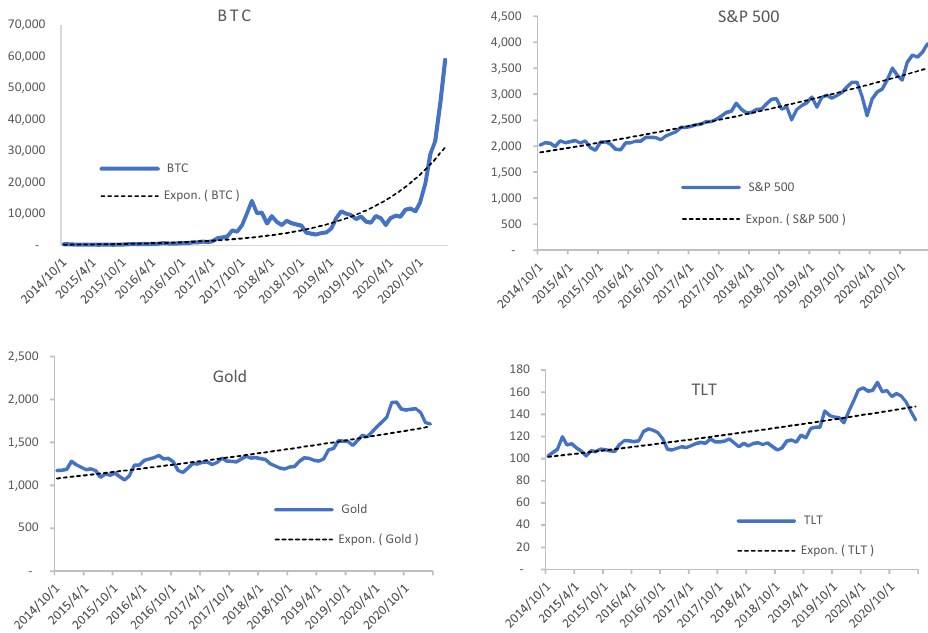
Figure 4. The results of actual and predicted prices for four financial assets. Institutional demand has become more active in the past year. While there is no sin- gle way to split Bitcoin demand. Table 2 demonstrates recent Institutional announcements of Bitcoin adoption. Table 2. Notable recent Institutional announcements of Bitcoin adoption. Date